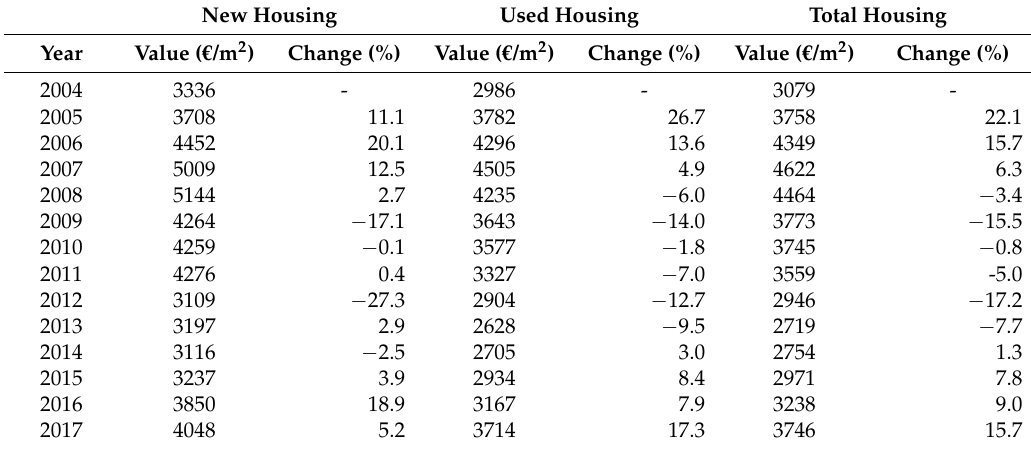
Table 7. Evolution of the sale price of housing in Barcelona